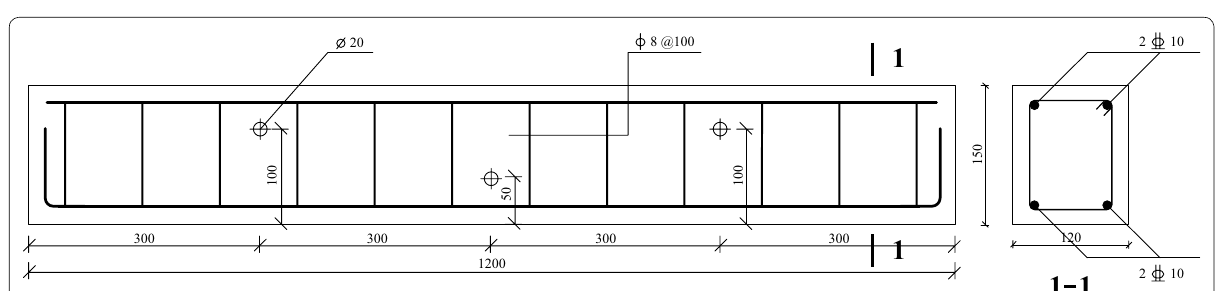
Fig. 2 Dimensions and reinforcement of beams